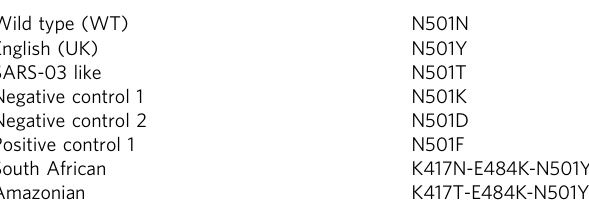
Table 1 Variants considered in the present